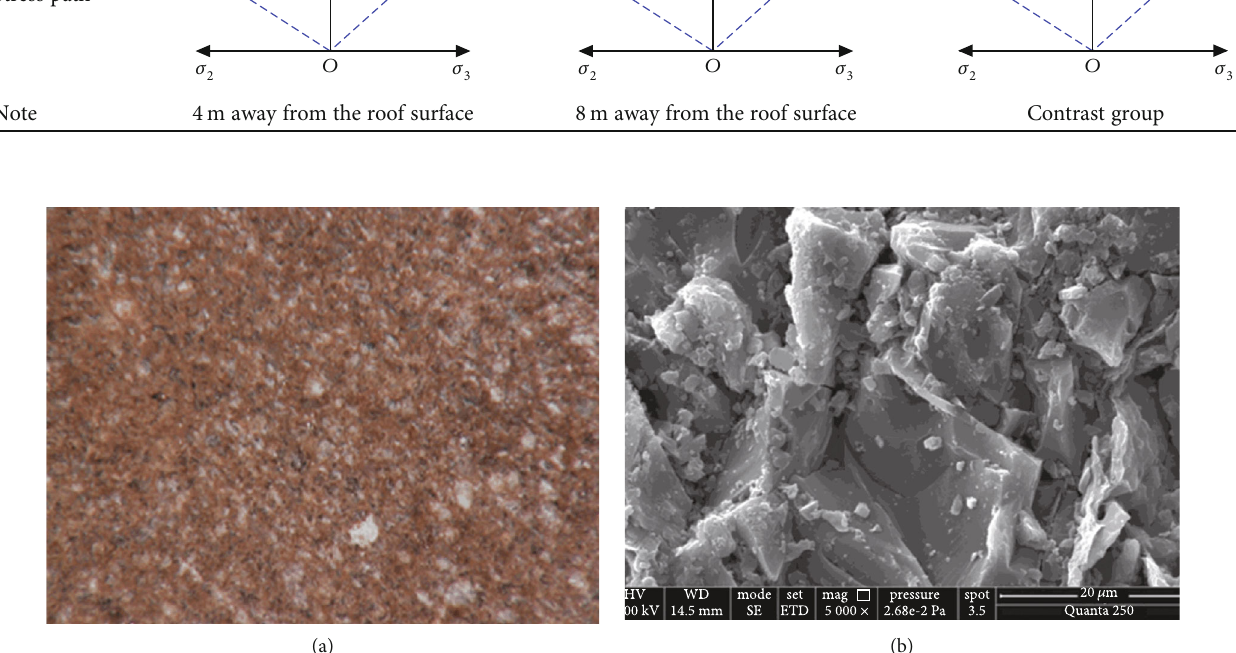
Figure 8: Optical microscopy and SEM features of red